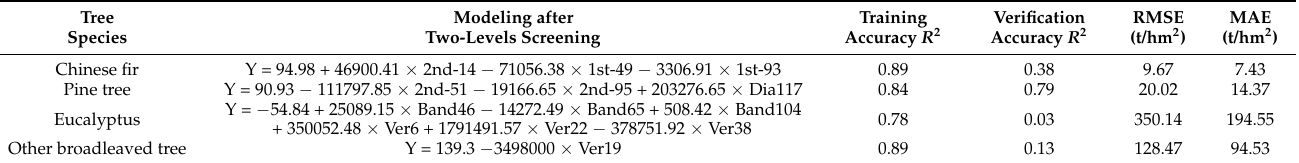
Table 7. Accuracy of AGB model based on hyperspectral